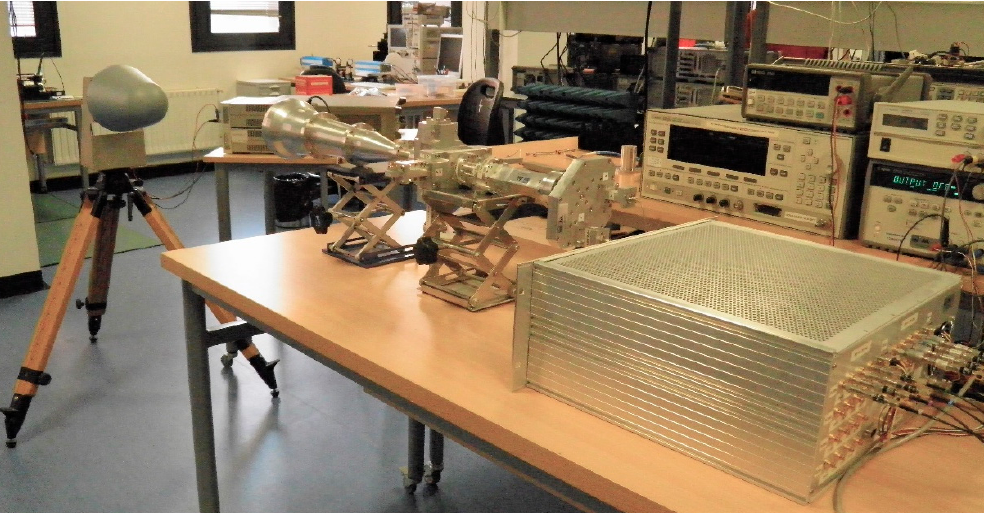
Figure 7. Radiometer measurement experimental set-up.